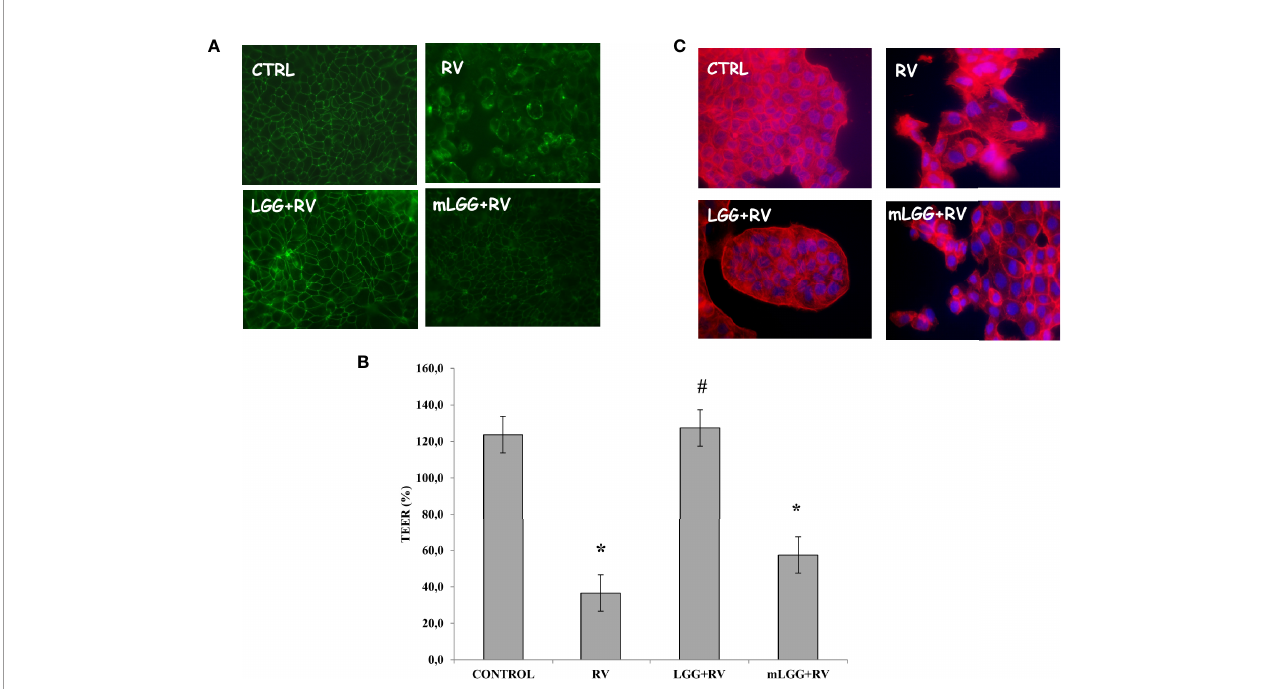
FIGURE 3 | Effect of LGG on cytotoxic damage induced by RV. (A) Occludin, as marker of tight junction structure, was evaluated with immuno fl uorescence in Caco-2 cell monolayers infected with RV preincubated with LGG or mLGG as described in the Methods Magni fi cation: 400X. (B) Caco-2 cells monolayers were infected with RV following preincubation in the of LGG or mLGG and transepithelial electrical resistence (TEER) was evaluated as described in the Methods together with uninfected cells; [*p < 0.05 vs CTRL; # p < 0.05 vs RV]. (C) Phalloidin, as marker of cytoskeleton architecture, was used with immuno fl uorescence in Caco-2 cell monolayers infected with RV preincubated with LGG or mLGG as described in the Methods Magni fi cation: 400X.